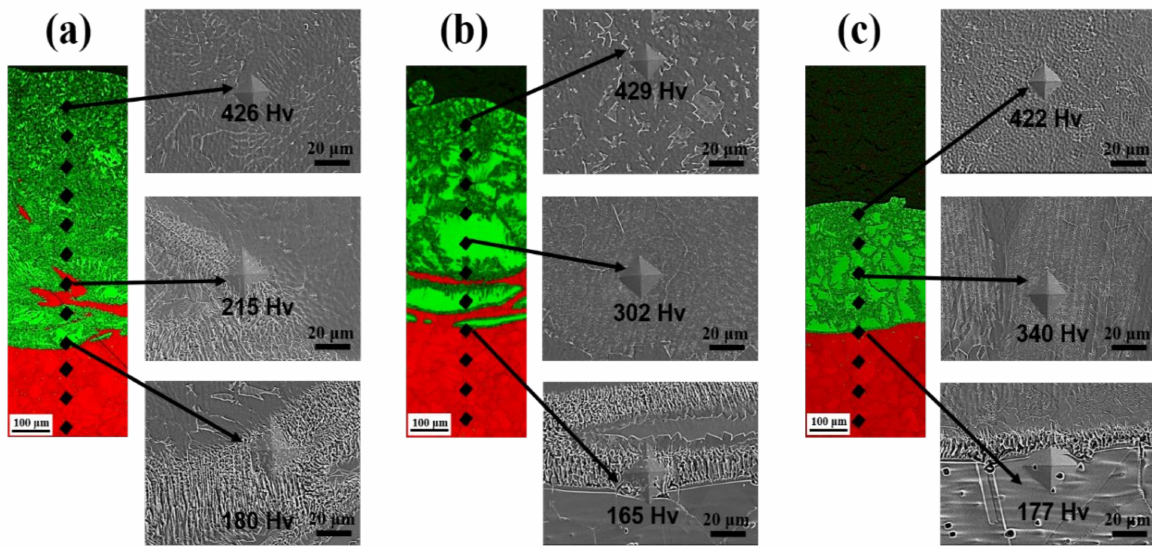
Figure 8. Correlation between the hardness distribution and microstructure of a specific area in each clad specimen at various laser traverse speeds: ( a ) 12 mm/s, ( b ) 14 mm/s, and ( c ) 16